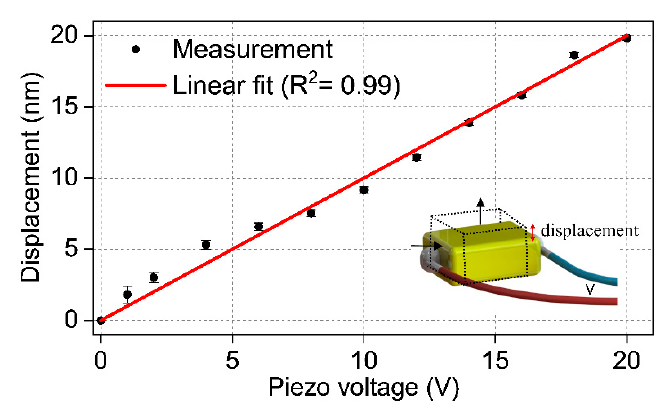
Figure 8. Measured displacement value of the piezo transducer at different voltage values. The inset shows the longitudinal displacement of the piezo when voltage is applied.